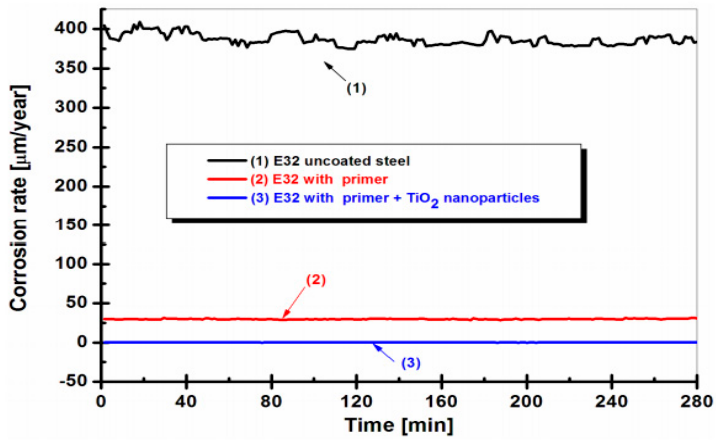
Figure 12. The variation of corrosion rate vs. time of three surfaces in a marine environment [117].